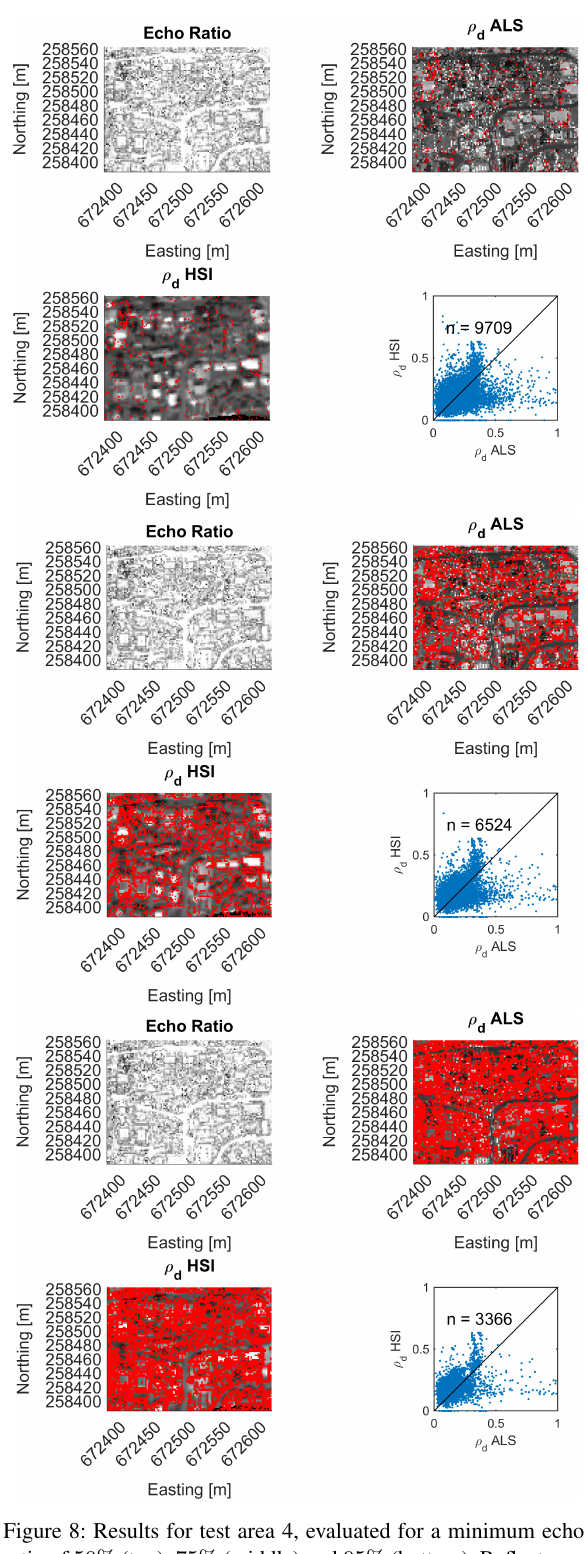
Figure 8: Results for test area 4, evaluated for a minimum echo ratio of 50% (top), 75% (middle) and 95% (bottom). Reflectance values are shown in grayscale from 0 (black) to 1 (white) and the echo ratio analogously. Pixels excluded from the analysis due to an echo ratio below the respective threshold are shown in